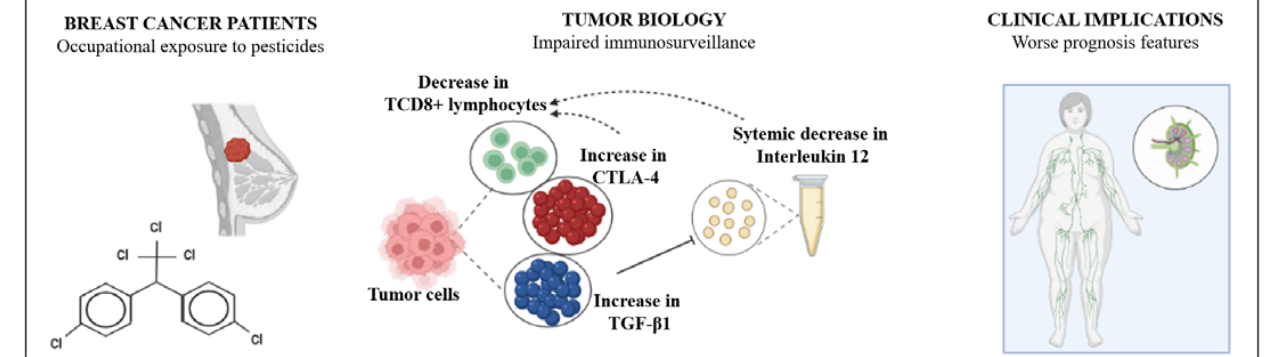
Figure 6. Pesticide-induced immune deregulation may worsen the prognosis in women with breast cancer from the intermediate risk of death and recurrence. Women diagnosed with breast cancer occupationally exposed to pesticides exhibit several significant alterations in the tumor microenvironment, affecting its immunosurveillance. Decreased TCD8+ lymphocyte infiltrate and increased expression of negative regulators of tumor-driven immune responses such as TGF- β and CTLA-4 are found in tumors from pesticide-exposed women compared to the unexposed ones. In addition, reduced levels of circulating interleukin 12 are reported, reducing the anti-tumor arsenal of pesticide-exposed women. This immunocompromised scenario may result in a worse clinical prognosis since women from the exposed group have more metastasis than the unexposed ones.